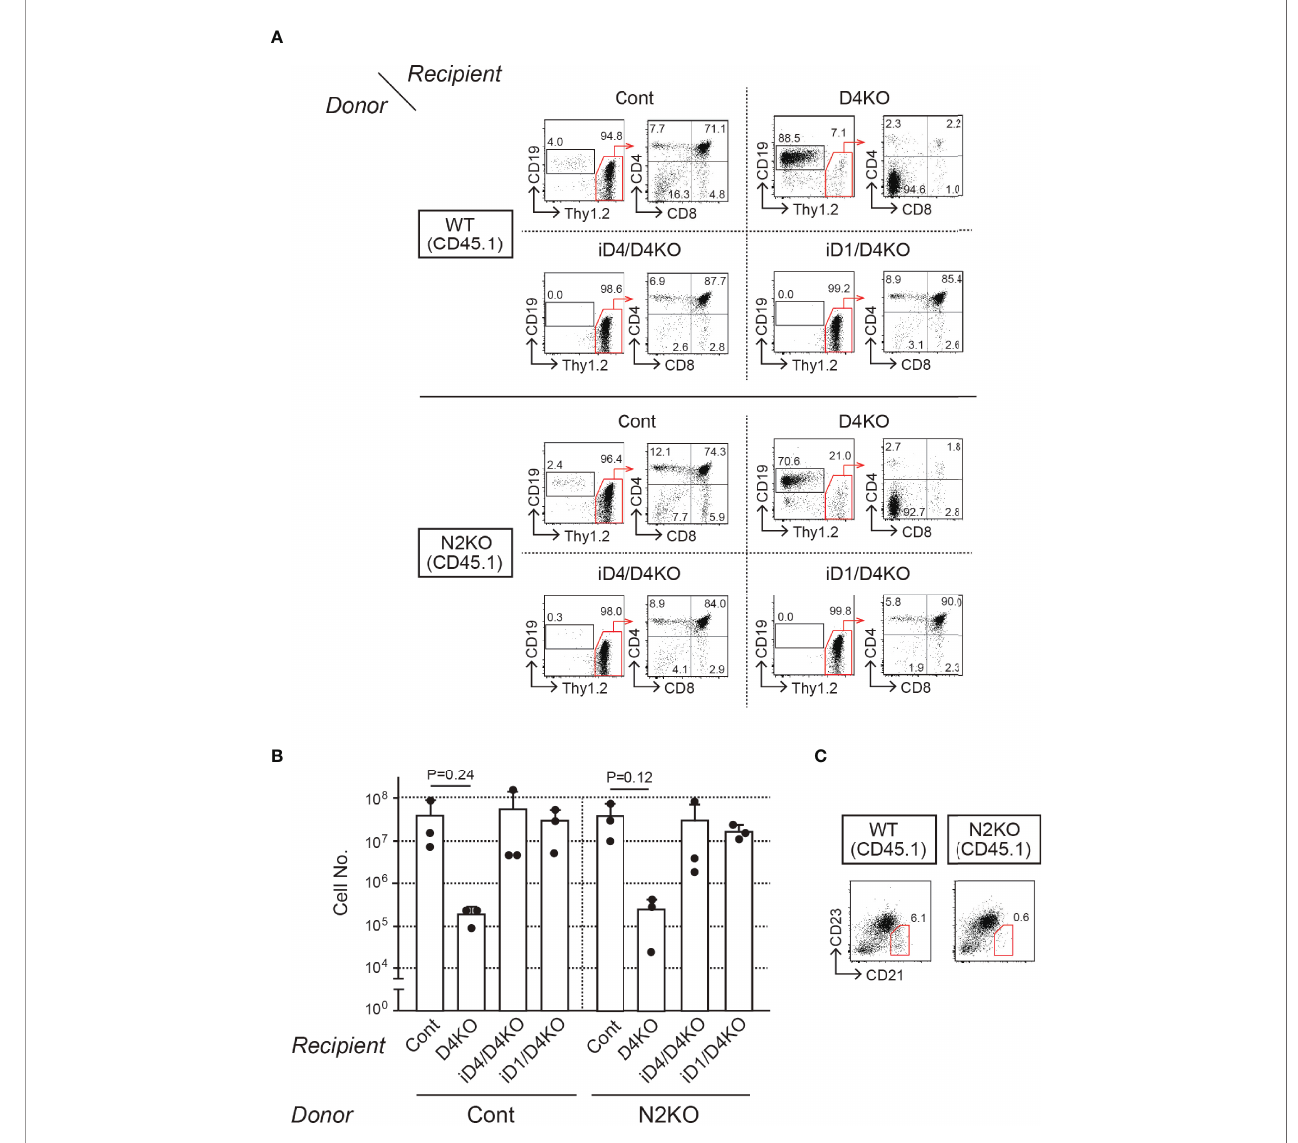
FIGURE 4 | T-cell development from Notch2 -de fi cient BM cells in the thymus of iD4 and iD1 mice. Age-matched control (WT) or Notch2 -de fi cient (N2KO) BM cells were obtained from Notch2 f/f or Rosa26 CreERT2 Notch2 f/f mice (CD45.1) 1 week after the administration of tamoxifen. BM chimeric mice were prepared in irradiated (6 Gy) C57 BL/6 mice (CD45.2) with Notch2 -de fi cient BM and analyzed 4 weeks after the reconstitution ( Supplementary Figure 3A ). (A) Flow cytometric analysis was performed using the thymocytes from BM chimeric mice with control (WT) or Notch2 -de fi cient (N2KO) BM cells ( Donor ) in Dll4 f/f (Cont), Dll4 f/f FoxN1-Cre (D4KO), iD4 Dll4 f/f FoxN1-Cre (iD4/D4KO), or iD1 Dll4 f/f FoxN1-Cre (iD1/D4KO) mice as the recipients ( Recipient ). Numbers in the pro fi les indicate the relative percentages, in CD45.1 + cells (left panels, CD19 vs. Thy1.2) and CD45.1 + Thy1.2 + cells (right panels, CD4 vs. CD8), for each quadrant or fractions. (B) Thymic cellularity (mean ± SD) of BM chimeric mice in Dll4 f/f (Cont, n=3), Dll4 f/f FoxN1-Cre (D4KO, n=3), iD4 Dll4 f/f FoxN1-Cre (iD4/D4KO, n=3), or iD1 Dll4 f/f FoxN1-Cre (iD1/D4KO, n=3) mice is shown. There are no statistically signi fi cant differences found between control and Notch2 -de fi cient BM cells by Student ’ s t -test. Each closed circle indicates the number of thymocytes (CD45.1) in each mouse. (C) Representative CD21/CD23 pro fi les in the donor-derived B cells (CD45.1 + B220 + ) obtained from the spleen of BM chimeric mice with control (WT) or Notch2 -de fi cient (N2KO) BM cells in Dll4 f/f mice are shown. The red polygons and numbers in the pro fi les indicate the MZB cell fraction and their frequencies. Results represent three independent biological replicates (A, C)